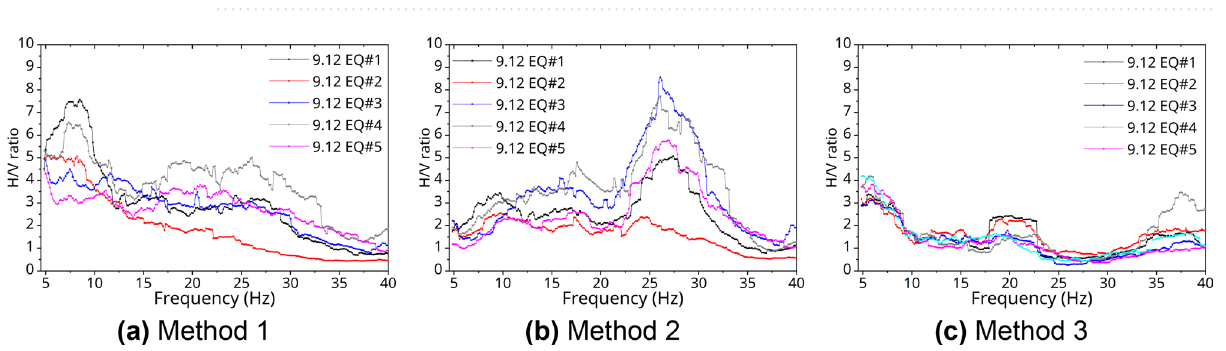
Figure 8. H/V Fourier spectra ratio with 9.12